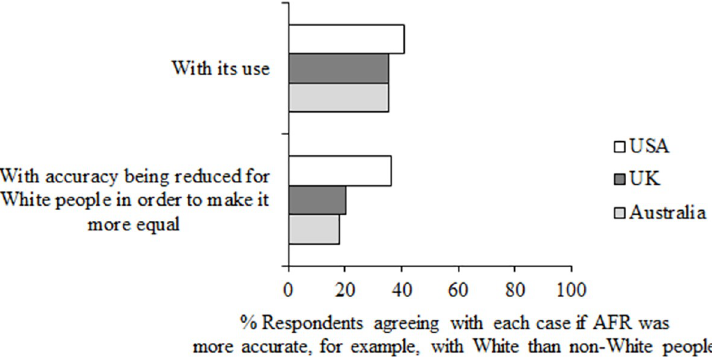
Fig 14. Questions 22–23 data. Percent respondents agreed (responding 4, 5 or 6 on the scale of agreement) with the use of AFR in these circumstances, if it was more accurate with White than non-White people (questions 22 and 23).